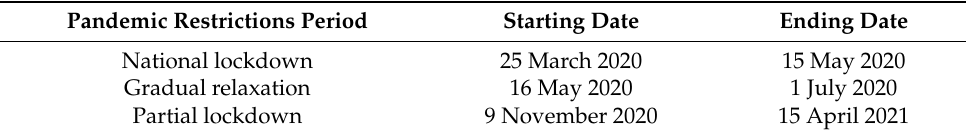
Table 1. Pandemics conditions in Romania.